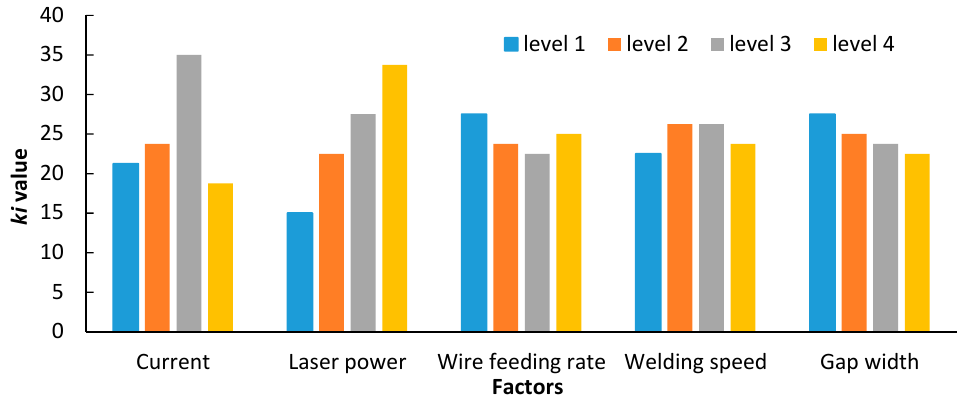
Figure 6. Relationships between the weld formation and the factors and levels.